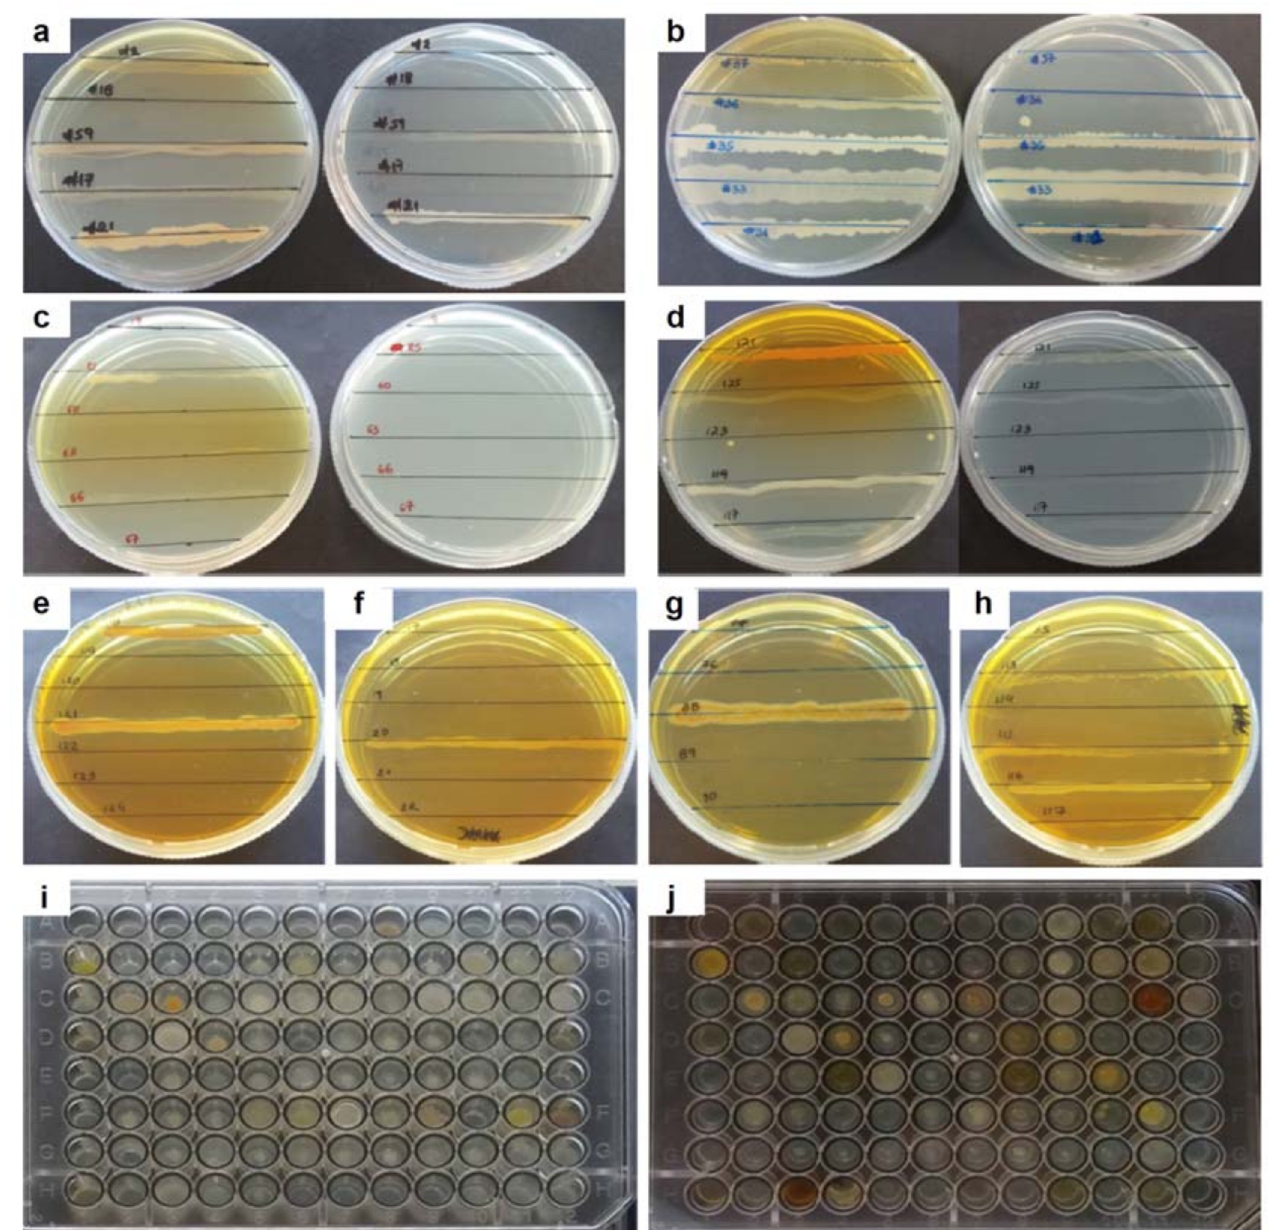
Fig 4. Sensitivity of bacterial isolates to xenobiotics. In a-d, the examples shown are xenobiotic sensitivity screens with 2-benzoxazolinone (BOA) in concentrations of 500 or 1000 μ g/mL (Petri dish on the left- or the right-hand side of each image, respectively). In e-h, the examples shown are xenobiotic sensitivity screens with 250 μ g/mL of 2-aminophenol (2AP). In i and j, the xenobiotic sensitivity screens were repeated for monocultures grown in 96-well agar plates, and the example shows the results for 96 (of 107 total) bacterial isolates screened in the absence (i) or the presence (j) of BOA (500 μ g/mL). Identical screens were also performed with 1000 μ g/mL of BOA or 250 μ g/mL of 2AP (not shown). In a-d, the displayed bacterial isolates are as follows: in a, isolates #2, #18, #59, #17 and #21; in b, isolates #37, #36, #35, #33 and #31; in c, isolates #19, #25, #60, #63, #66 and #67; in d, isolates #121, #125, #123, #119 and #117; in e, isolates #118, #119, #120, #121, #122, #123 and #124; in f, isolates #17, #18, #19, #20, #21 and #22; in g, isolates #87, #76, #88, #89 and #90; in h, isolates #105, #113, #114, #115, #116 and #117 (Table G in S1 File for details).